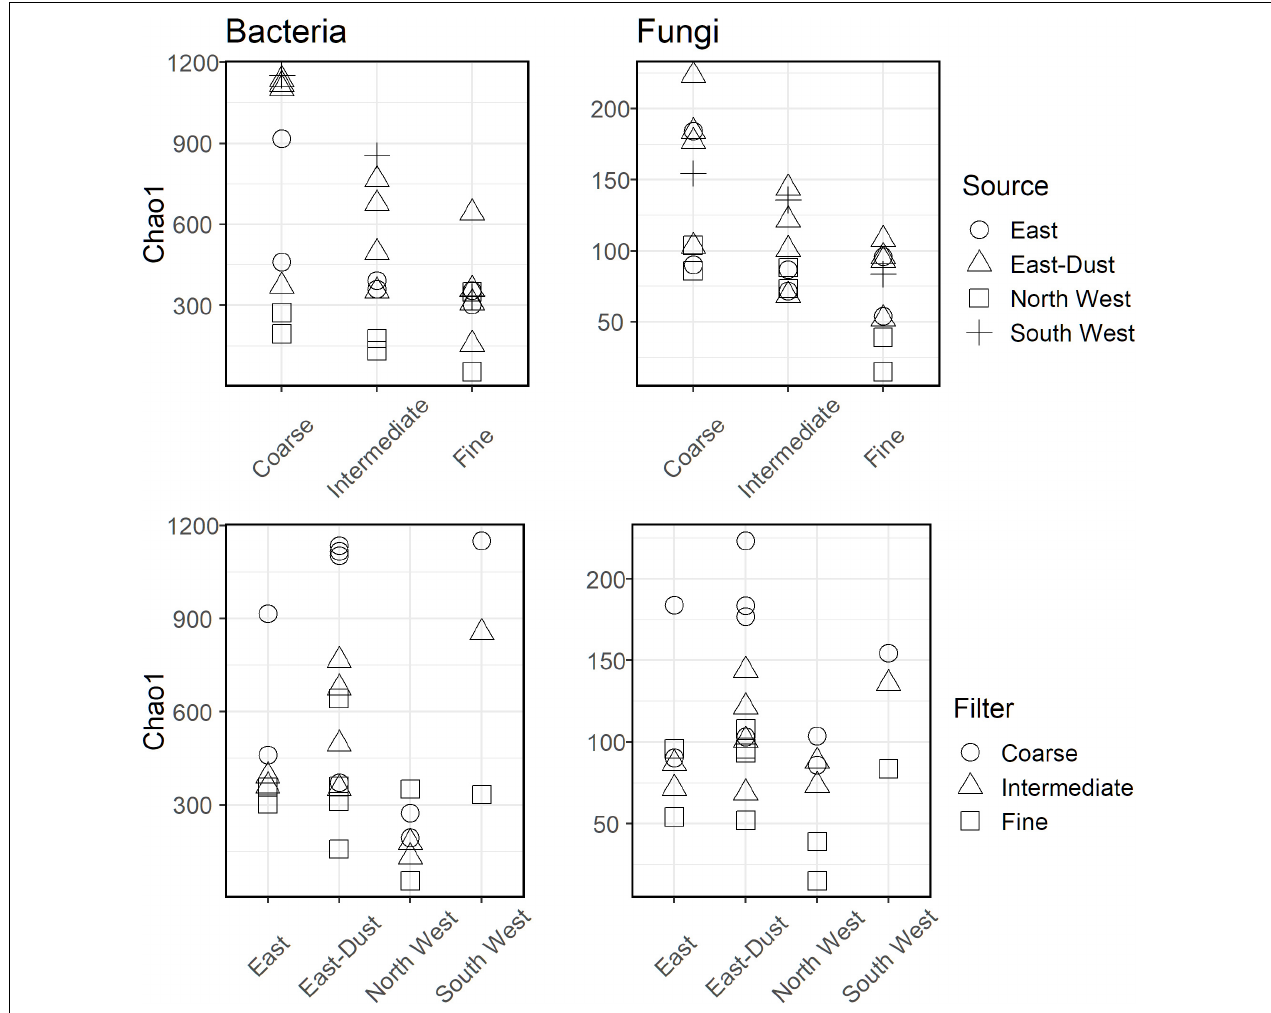
FIGURE 3 | Chao1 diversity for bacteria (Left) and fungi (Right) over the different aerosol sources and particle